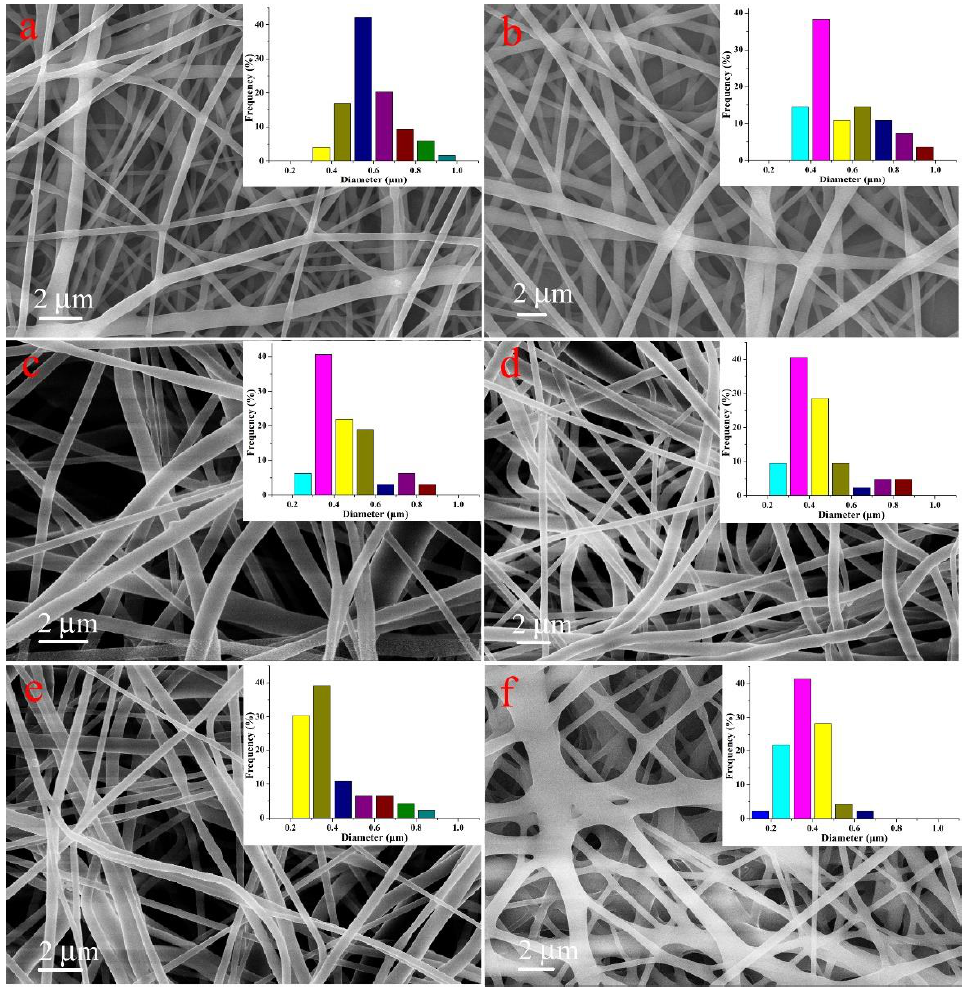
Figure 2. SEM images and diameter distribution histograms of neat PCL fibers ( a ), PCL/(10%)PCD ( b ), PCL/(20%)PCD ( c ), PCL/(30%)PCD ( d ), PCL/(40%)PCD ( e ), and PCL/(50%)PCD ( f ).